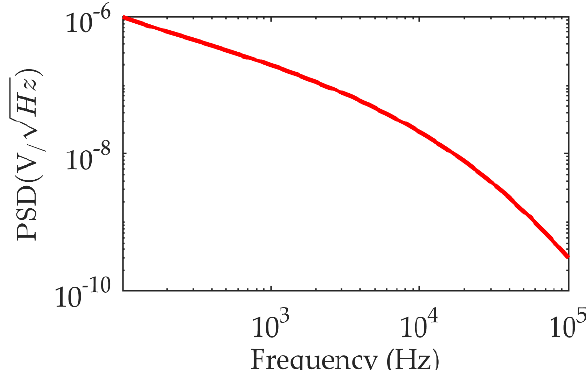
Figure 3. The PSD of TEM forward response.